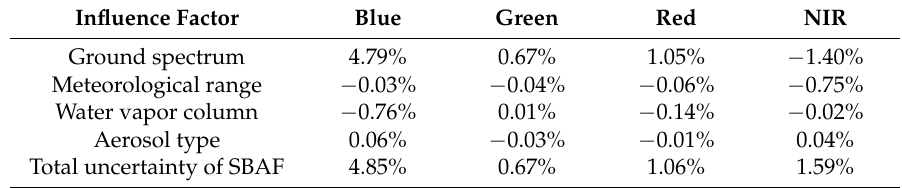
Figure 7. Spectra used for SBAF calculation, where Dunhuang is raw spectrum and sand is new spectrum. Table 7. Total uncertainty caused by ground spectrum, atmosphere, and aerosol type.